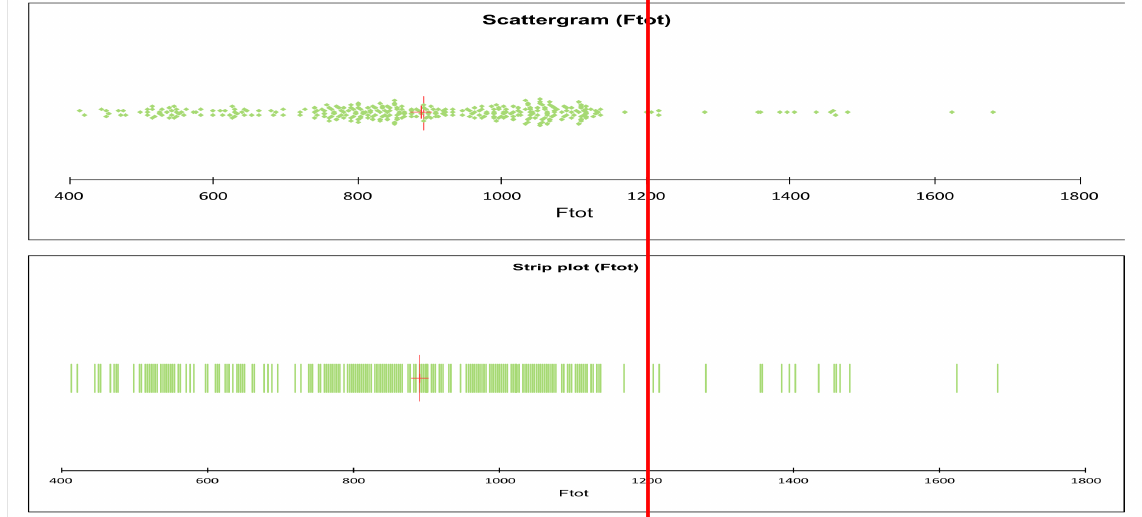
Figure 20. Scatter grams and strip plots of the distribution of the daily water consumption of the campus; events with consumption exceeding 1200 m 3 (average water consumption + 1.5 standard deviation) could be related to leakage (line in the red